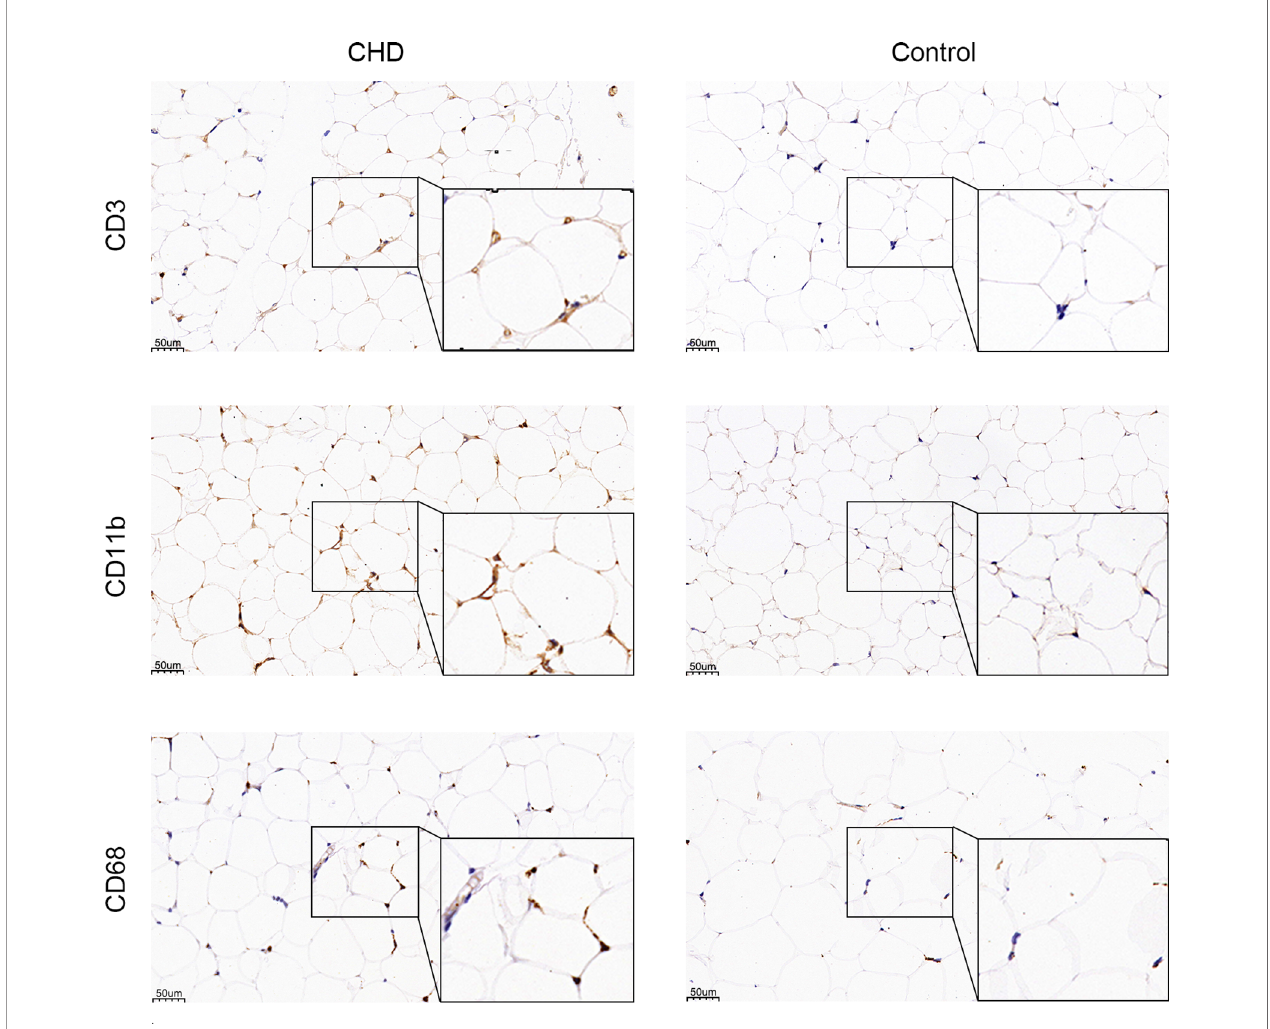
FIGURE 6 | IHC staining of CD68, CD11b, and CD3. CD68, CD11b, and CD3 protein are stained in brown.